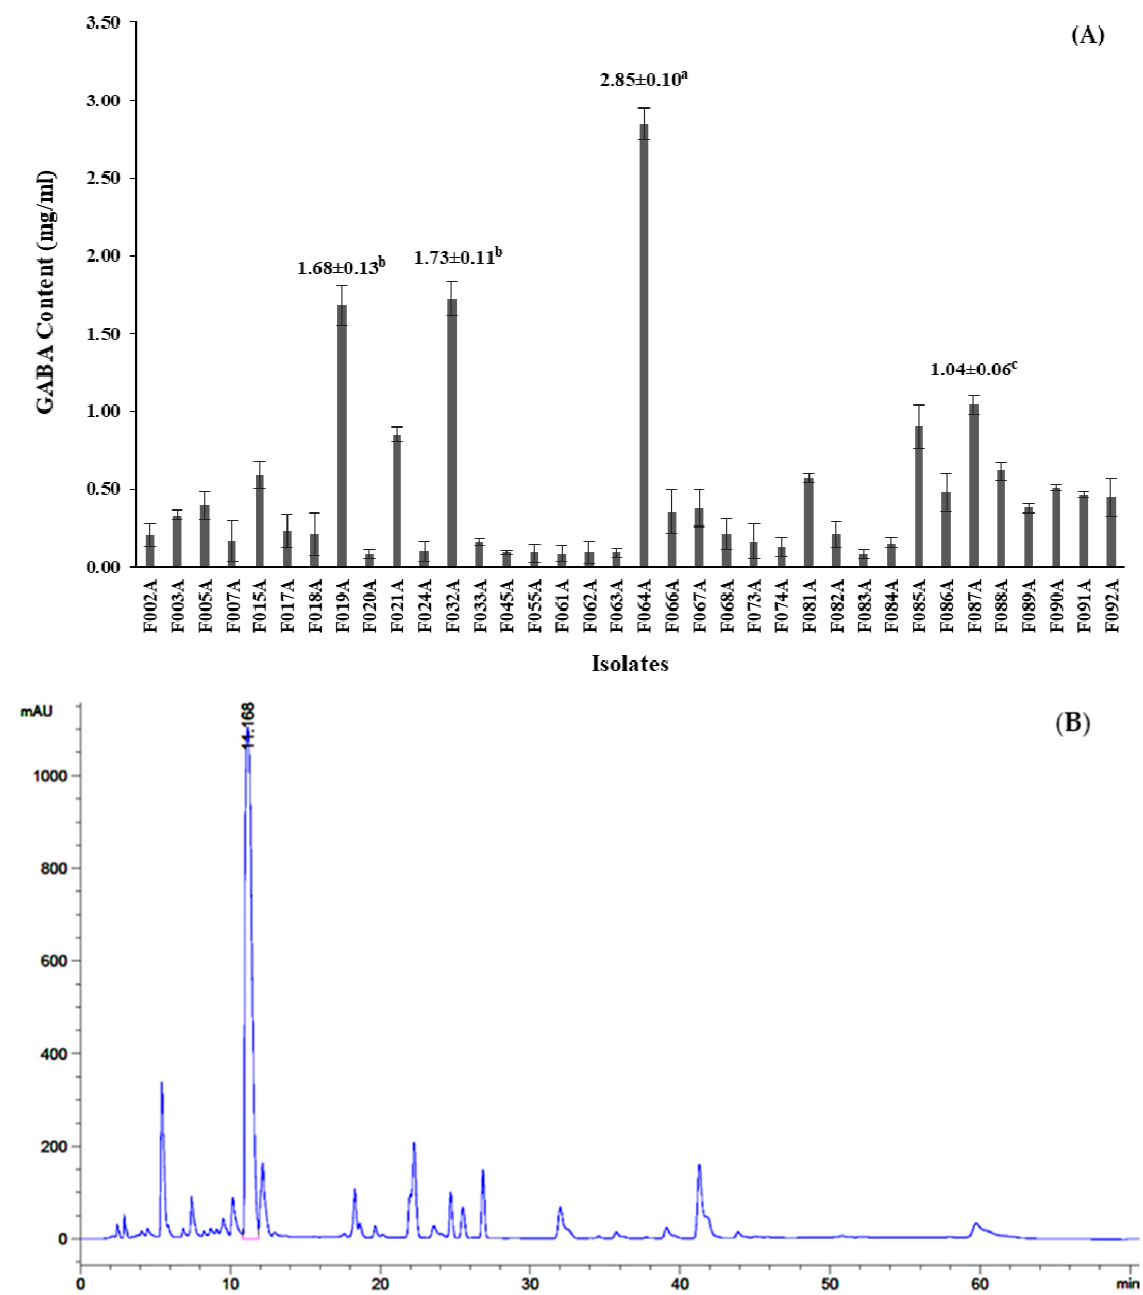
Figure 2. Screening of GABA-producing LAB; ( A ) GABA content (mg/mL) from 36 isolates after 24 h of cultivation in De Man, Rogosa and Sharpe (MRS-MSG) broth. The bars represented mean ± standard deviation (S.D., n = 2); ( B ) chromatogram showed peak area (mAU) of GABA content (retention time at 11.168) detected by high-performance liquid chromatography (HPLC) after being derivatized with phenylisothiocyanate (PITC) solution. The statistical analysis was performed by using one-way analysis of variance (ANOVA) Values with different superscript letter in Figure 2A are considered statistically significant difference at p < 0.05 .